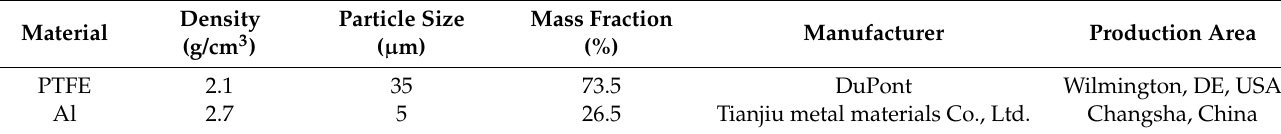
Table 4. Raw materials for reactive materials.